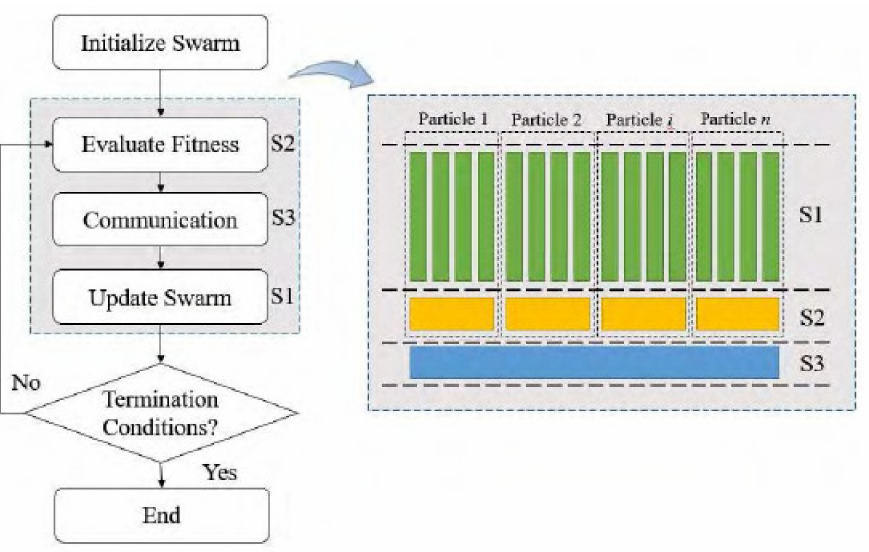
Figure 12. Flow chart of quantum-behaved particle swarm optimization (QPSO) [50] (Reprinted with permission from ref. [50]. Copyright 2021 IEEE).